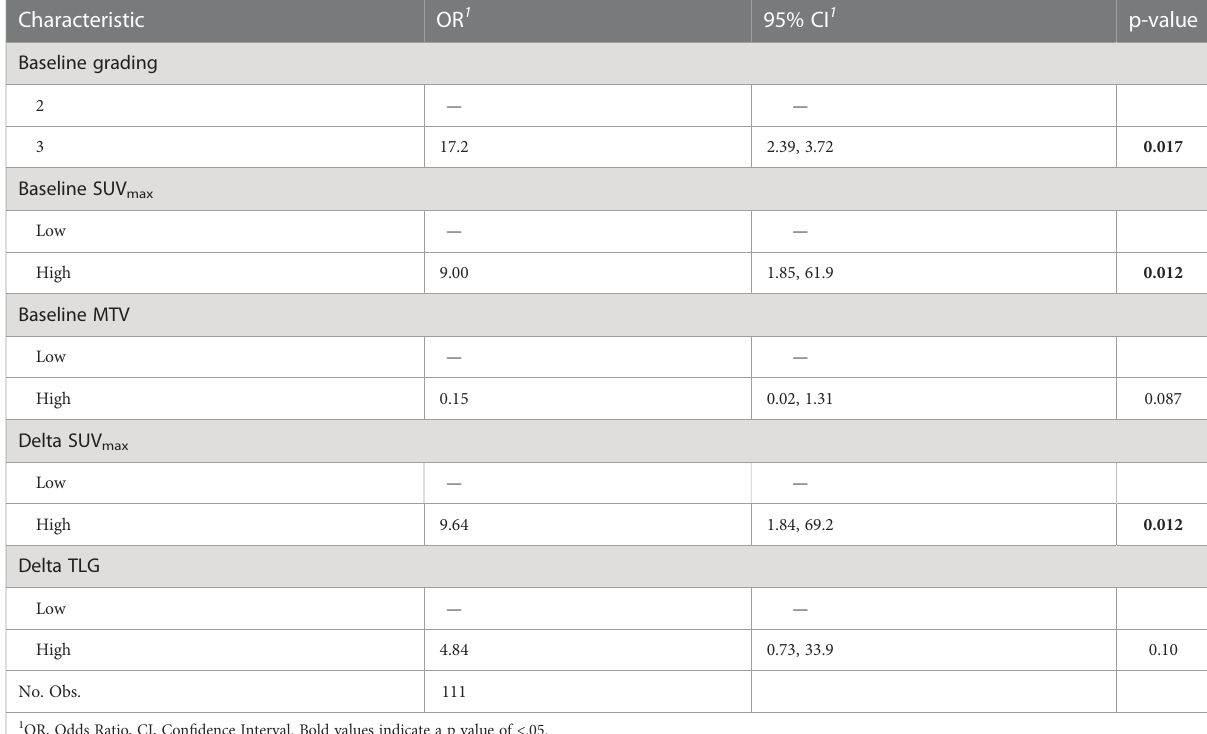
TABLE 3 Multivariable logistic regression model for pCR.